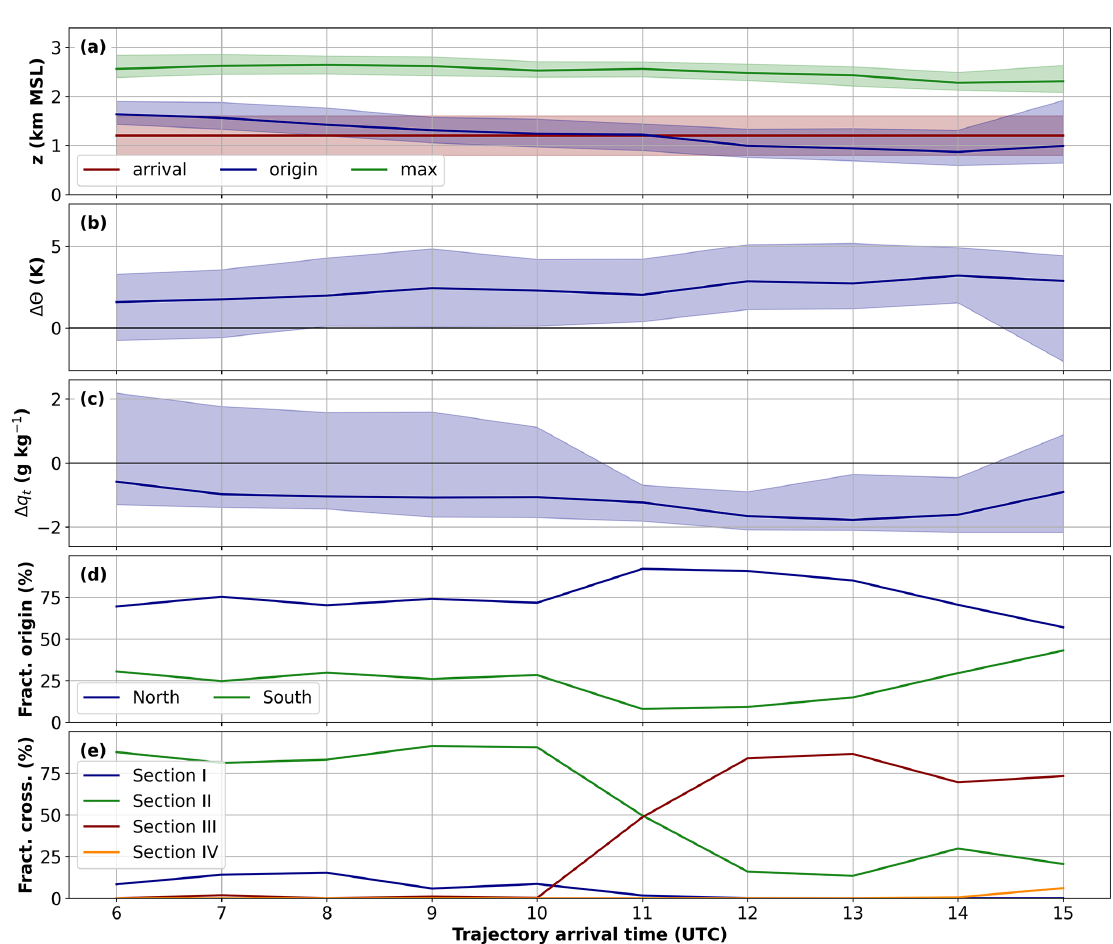
Figure 10. Temporal evolution of trajectory properties for trajectories arriving in Innsbruck from 06:00 to 15:00UTC on 29 October 2017 between 700 and 1700ma.m.s.l. Upstream conditions are averages between 5 and 6h before the arrival in Innsbruck. (a) Upstream trajectory height (blue), maximum trajectory height (green), and trajectory arrival height in Innsbruck. The distribution of the arrival height in Innsbruck is indicated in red. Difference in (b) potential temperature and (c) total water content between the upstream condition and at the arrival in Innsbruck. The median in (a) – (c) is indicated by a thick line and the range between the 10th and 90th percentile as color shading. (d) Fraction of trajectories starting either north (blue) or south (green) of 47.2 ◦ N. (e) Fraction of trajectories crossing the Inn Valley boundary at four different sections as defined in Sect.